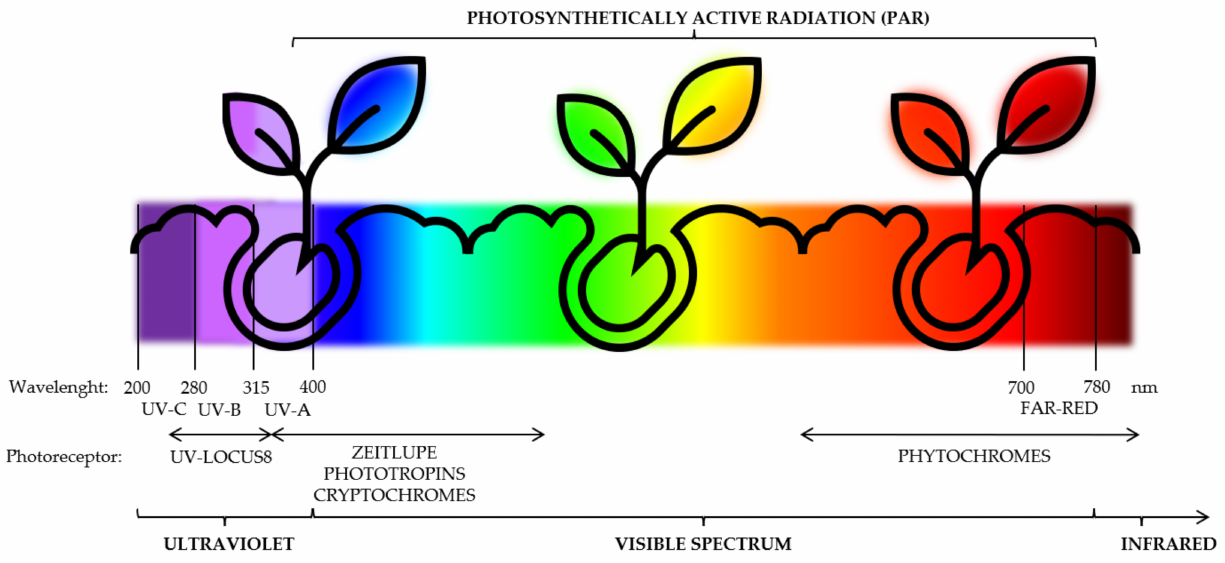
Figure 1. Main photoreceptors implied in light capture according to the UV and visible light